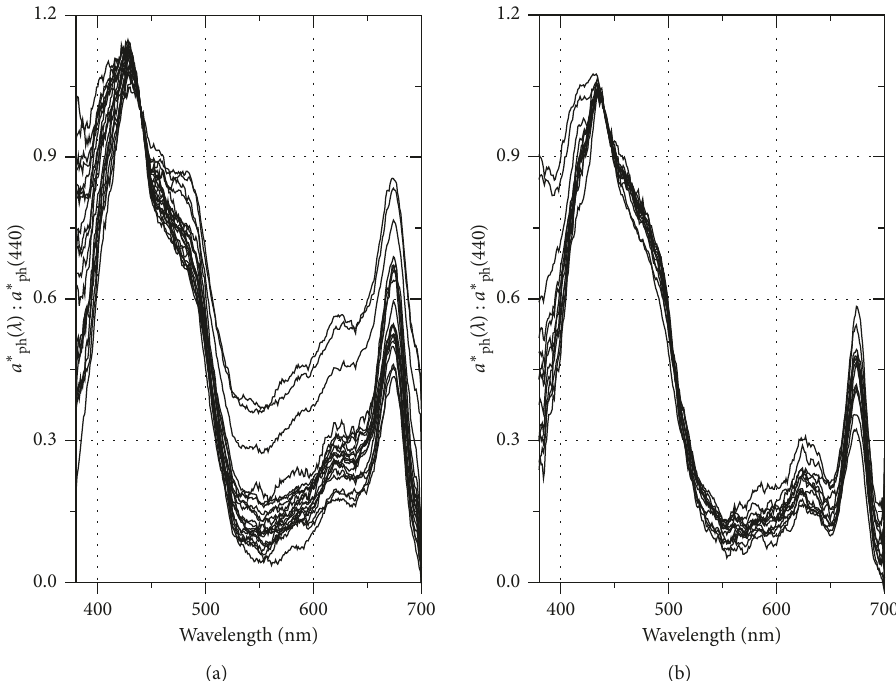
Figure 7: Specific absorption spectra normalized to a